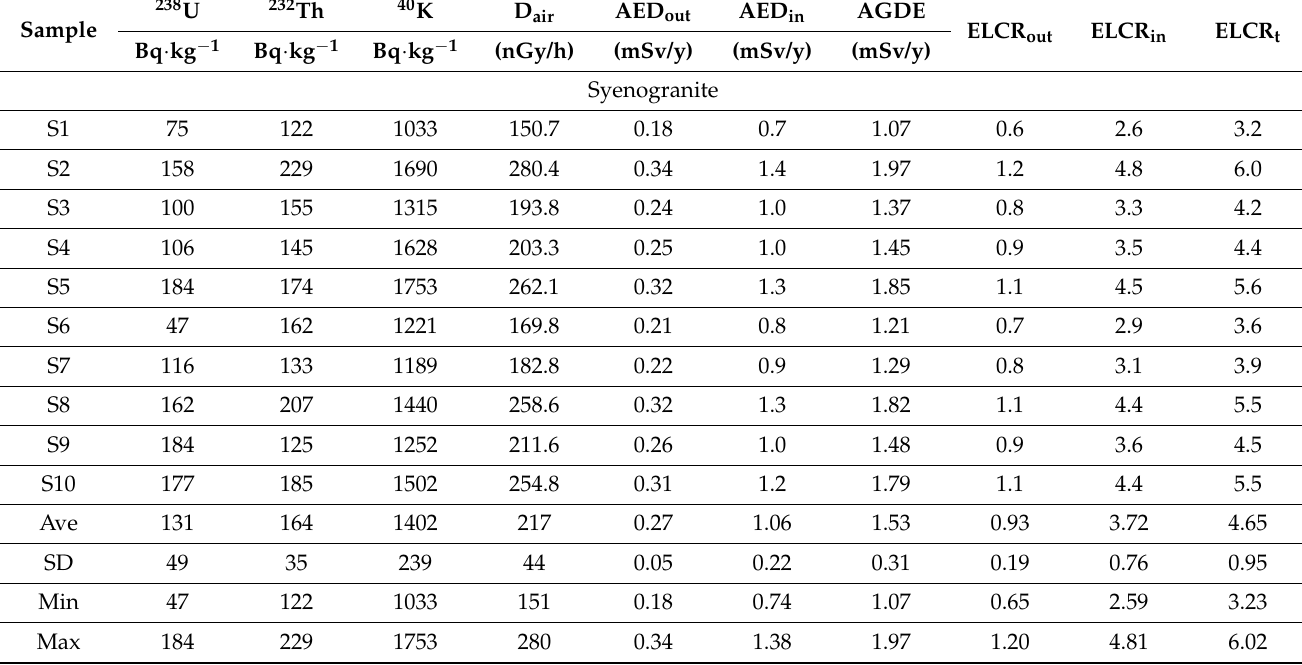
Table 3. Activity concentrations of 238 U, 232 Th and 40 K (Bq · kg − 1 ) and the associated